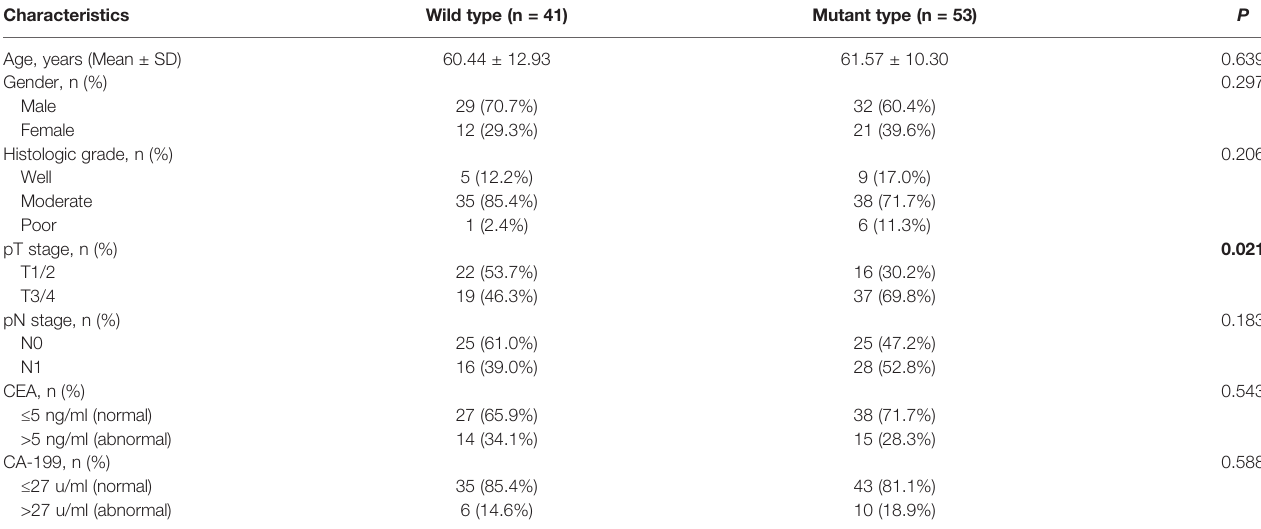
TABLE 1 | Patient baseline characteristics for genotype (KRAS/NRAS/BRAF) prediction.